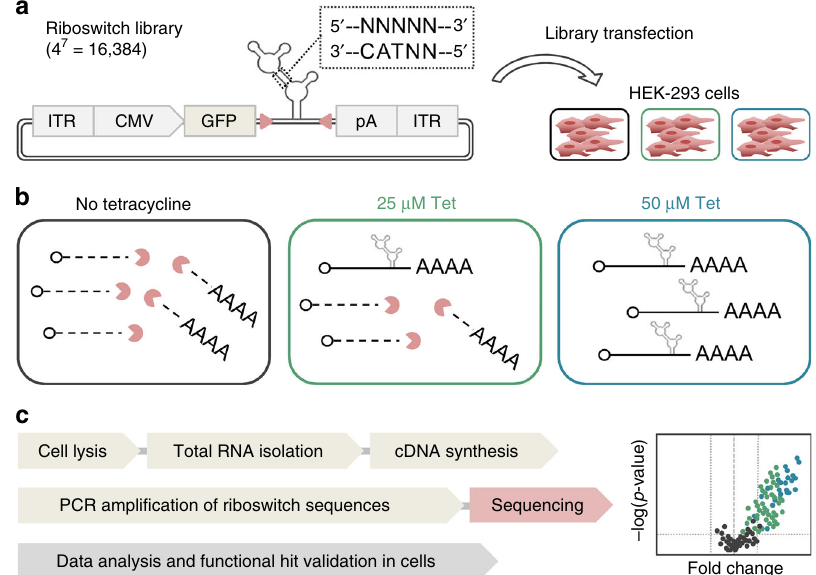
Fig. 1 Principle and schematic work fl ow for the sequencing-based identi fi cation of functional riboswitches in human cells. a HEK-293 cells are transfected with a plasmid library harboring PCR-binding site (red arrowheads)- fl anked aptazyme variants with a randomized motif (here: tetracycline (Tet)-hammerhead design). b Functional ON-switches are characterized by aptazyme auto-cleavage and mRNA-degradation in the absence of Tet, whereas upon Tet addition, cleavage is inhibited, resulting in stable mRNA. c Following cell lysis, RNA puri fi cation and reverse transcription into cDNA, riboswitch sequences are PCR-ampli fi ed and applied to amplicon-seq analysis. Functional sequences are identi fi ed from differential expression analyses (stimulated vs. unstimulated). ITR, inverted terminal repeat; CMV, cytomegalovirus; GFP, green fl uorescent protein; pA, polyadenylation